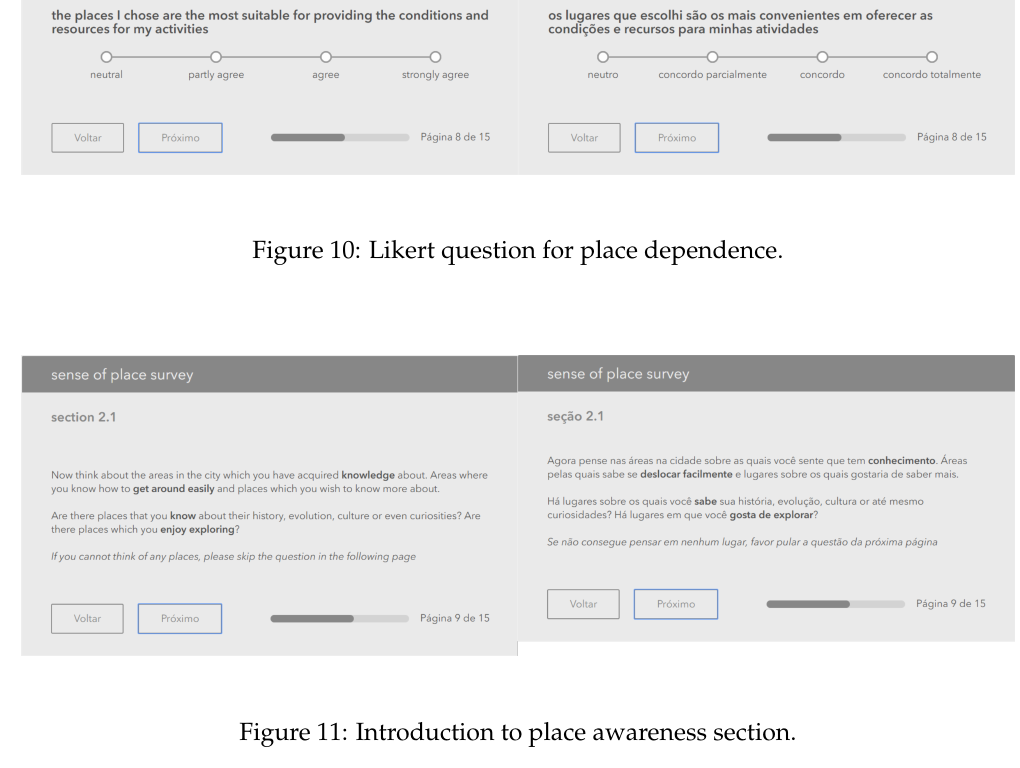
Figure 11: Introduction to place awareness section.